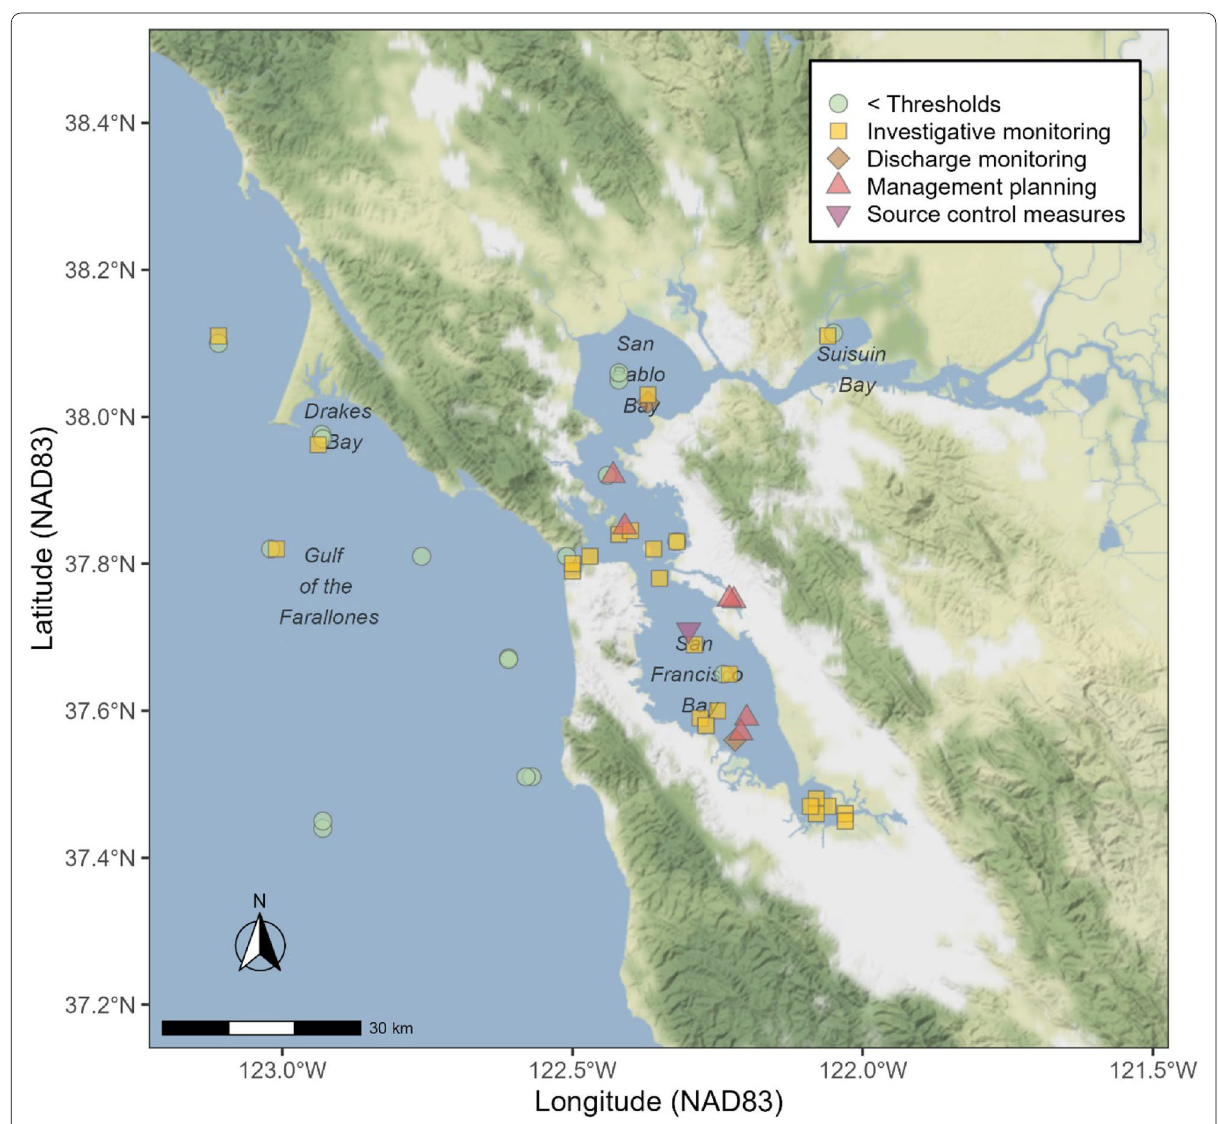
Fig. 4 Map of San Francisco Bay showing food dilution threshold risk exceedances based on corrected and rescaled surface water concentrations of microplastics collected using manta trawl. Points represent approximate coordinates of manta trawl sampling locations. Colors represent risk in relation to food dilution thresholds in Mehinto et al. ([42]; re-produced in Table S9). Greater risk can be seen within SFB and San Pablo Bay relative to open-ocean waters outside of the